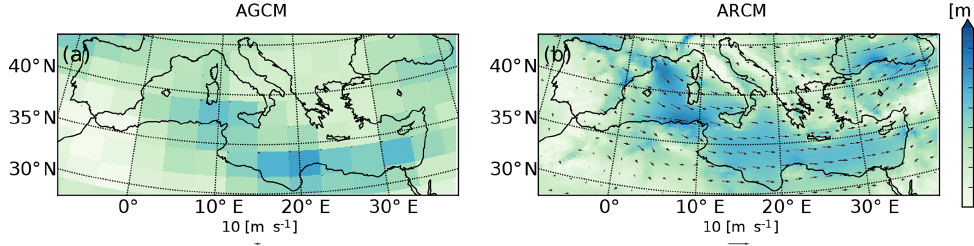
Figure 9. Winter wind speed in PICTRL for (a) the AGCM and (b) the ARCM.